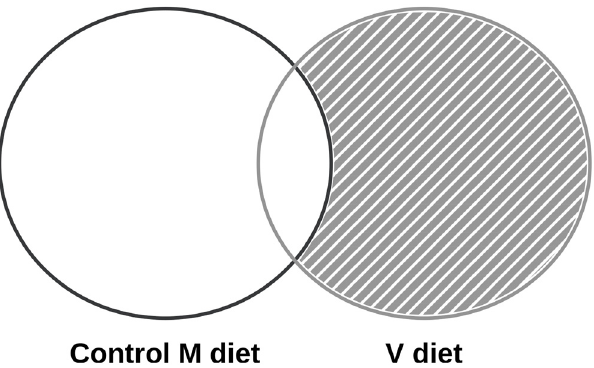
Fig 1. Transcriptomic analysis strategy. Venn diagrams show the numbers of differentially expressed probes (Adjusted P-value < 0.5) when compared the three isogenic lines when fed the control M diet (dark grey) and when fed the V diet (light grey). Probes found to be differentially expressed only with the V diet (V diet \ M diet C ) were identified as potential molecular markers linked to plant-based diet utilisation, and were thus kept for further analysis (hatched